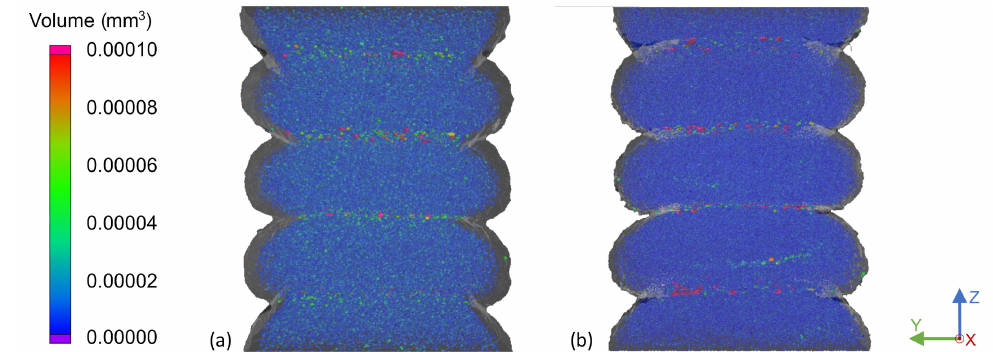
Figure 4. Front view of the pores of a single-strand specimen at a substrate temperature of ( a ) 200 °C and ( b ) 130 °C and a layer height of 1.0